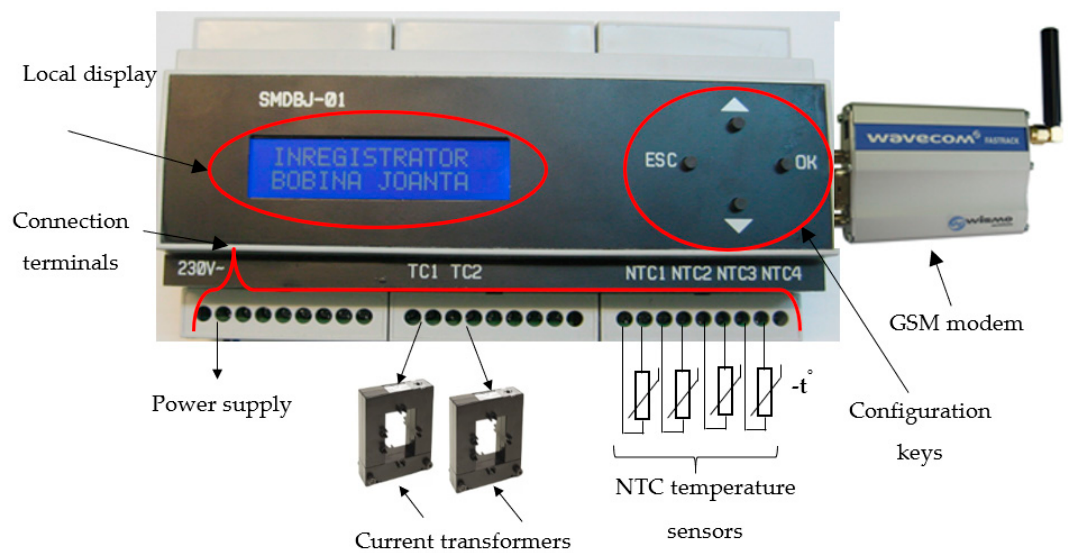
Figure 5. Image with monitoring and diagnosis device of impedance bonds.